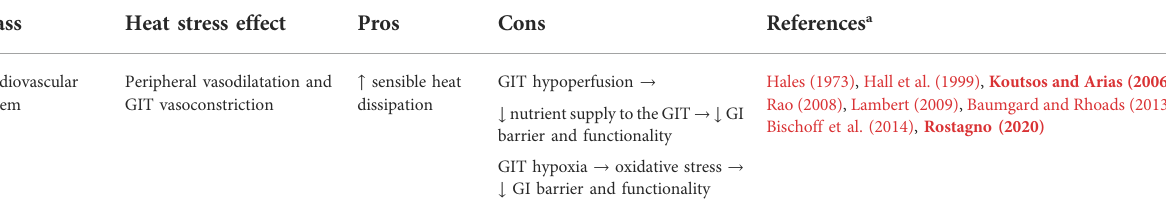
TABLE 5 Overview of heat stress effects on the cardiovascular system of